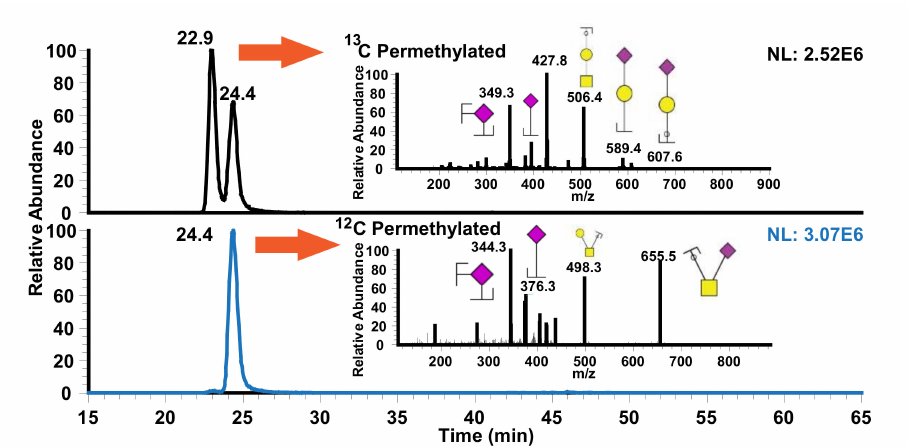
Figure 3. Separation of a reduced trisaccharide O -glycan derived from k-casein using PGC-LC-MS. Insets depict MS2 for the corresponding